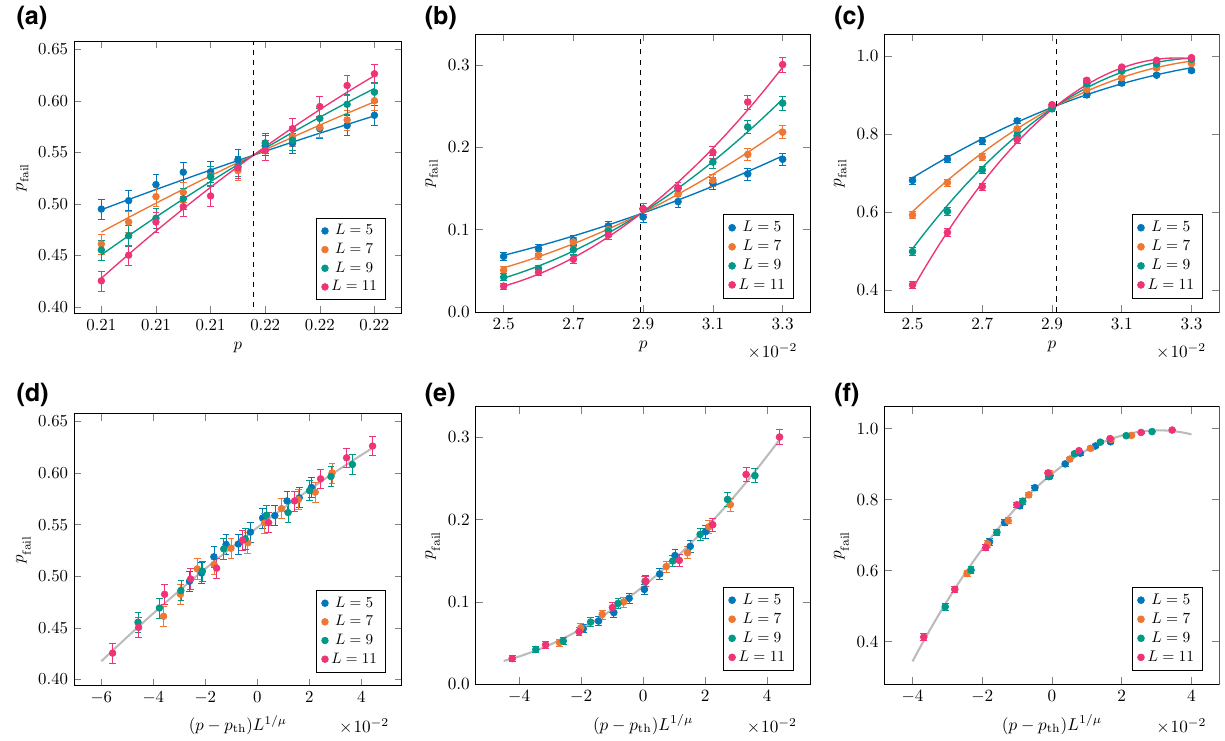
FIG. 9. Threshold fits for the 3D toric code using MWPM and BP+OSD to decode. In (a), we plot the logical error rate p fail as a function of the phase-flip error rate p , for values of p close to the threshold. The colored lines show the fit given by Eq. (E1), with parameters a 0 = 0.547, a 1 = 1.92, a 2 = − 4.04, μ = 1.04, and p th = 0.216 (dashed gray line). In (d), we show the same data using the rescaled variable x = ( p − p th ) L 1 /μ . Subfigures (b) and (e) show equivalent data for one round of single-shot error correction, with fit parameters a 0 = 0.119, a 1 = 3.04, a 2 = 22.9, μ = 1.01, and p th = 0.0289. Subfigures (c) and (f) show equivalent data for 16 rounds of single-shot error correction, with fit parameters a 0 = 0.873, a 1 = 7.99, a 2 = − 130, μ = 1.10, and p th = 0.0291. The error bars (cid:13) show the 95% confidence intervals p fail = ˆ p fail ± 1.96 p fail ( 1 − p fail )/η , where η ≥ 10 4 is the number of Monte Carlo